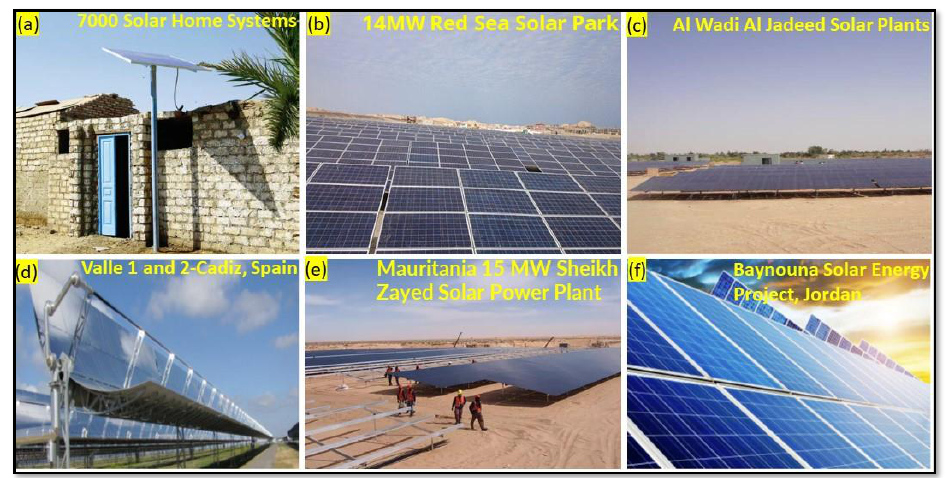
Figure 19. Solar projects in ( a – e ) Egypt and ( f ) in Jordan.